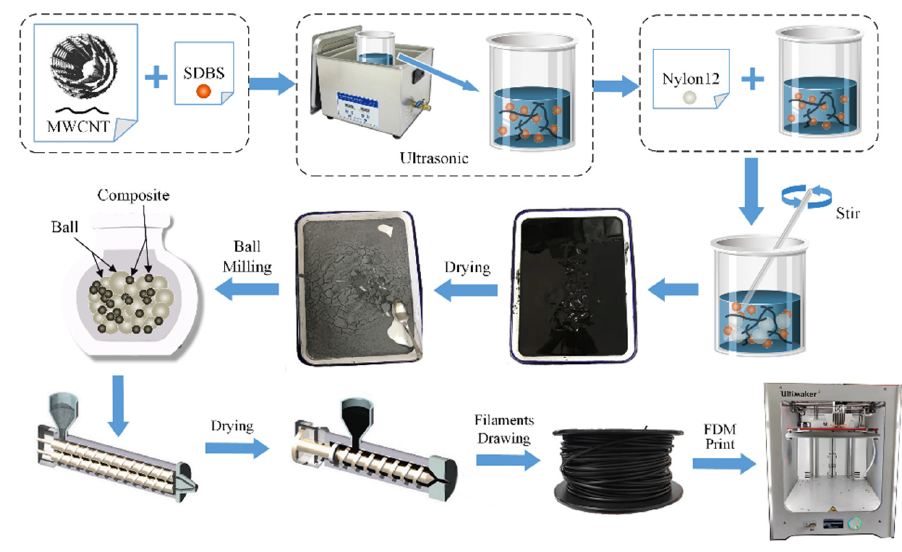
Table 1. Basic parameters of multi-walled carbon nanotubes.